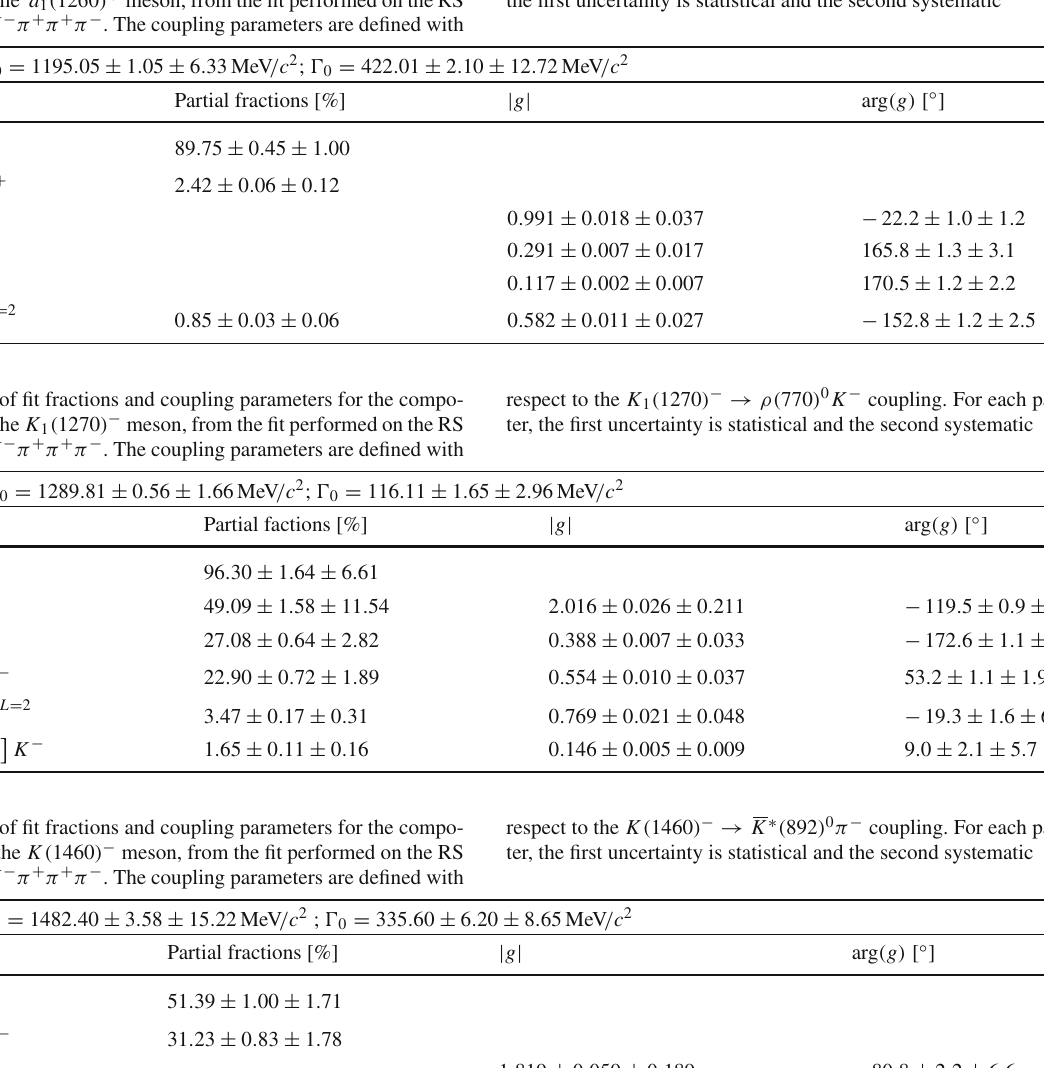
respect to the a 1 ( 1260 ) + → ρ( 770 ) 0 π + coupling. For each parameter, the first uncertainty is statistical and the second systematic